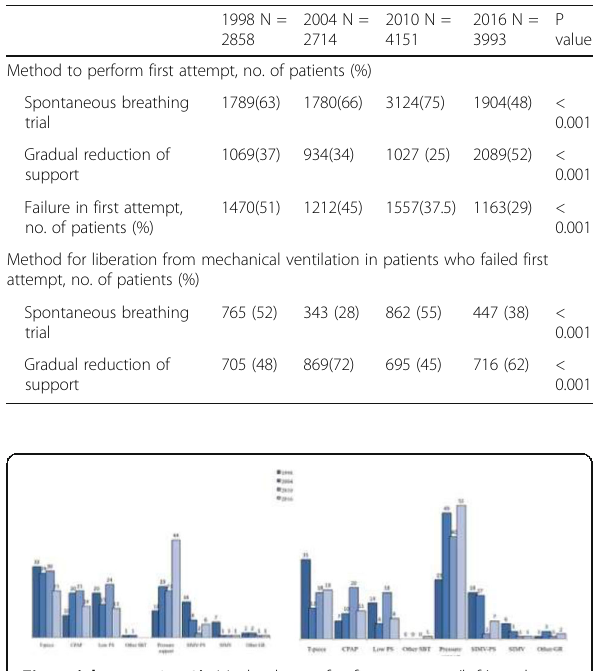
Fig. 1 (abstract 0142). Methods use for first attempt (left) and weaning